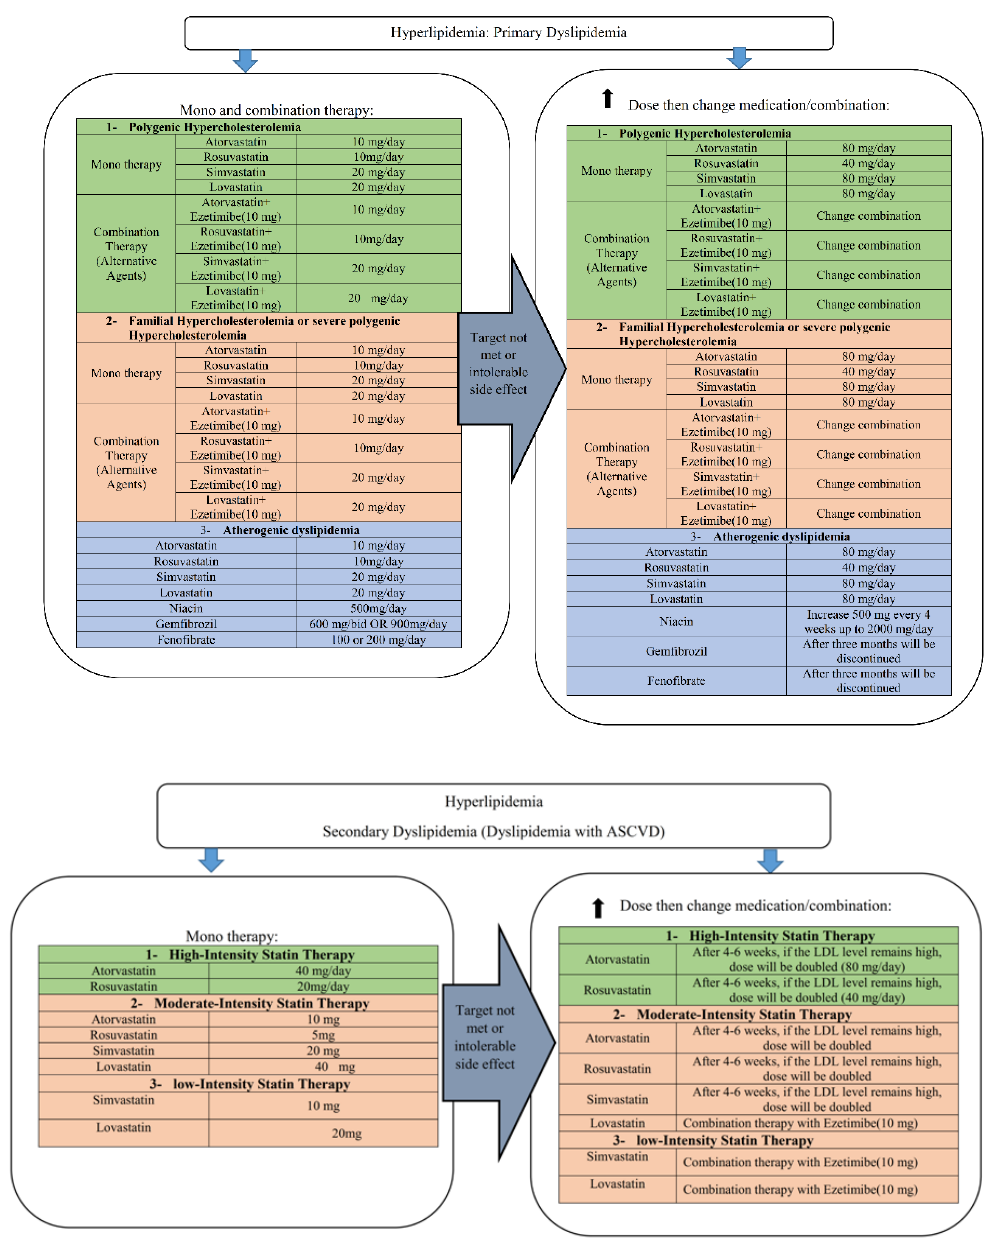
Figure A6. The di ff erent medication therapy scenarios in Figure 2F. The different medication therapy scenarios in hyperlipidemia.